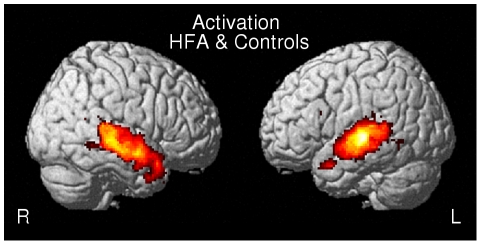
Conjunction map of activation between HFA and controls.